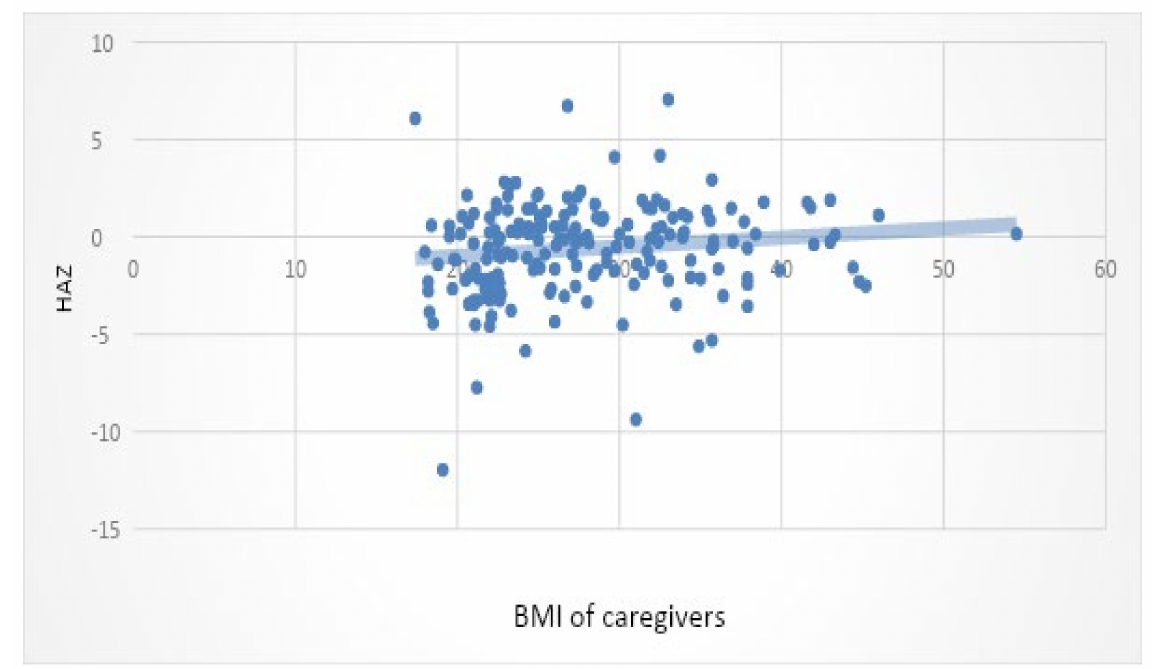
Figure 4. Scatter plot of HAZ and BMI of